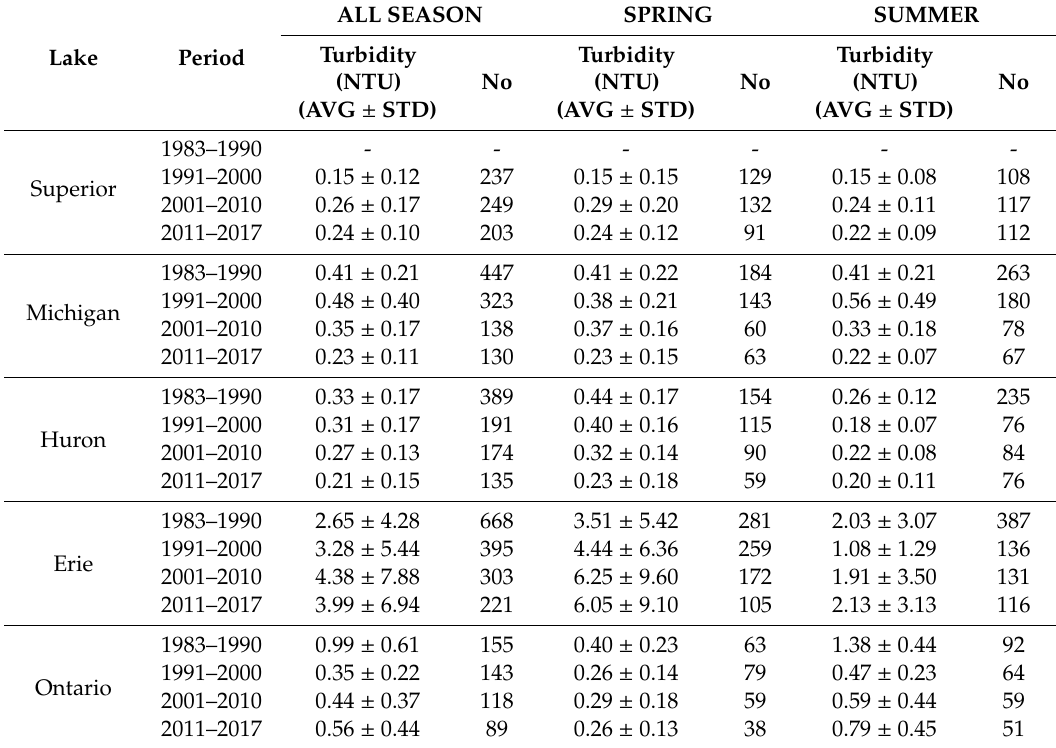
Table 1. Mean (AVG), standard deviation (STD), and data number (No) of in situ water turbidity in the individual lake of the Great Lakes for the four time periods, i.e., 1983–1990, 1991–2000, 2001–2010, and 2011–2017, for all months, spring months, and summer months (total data number is